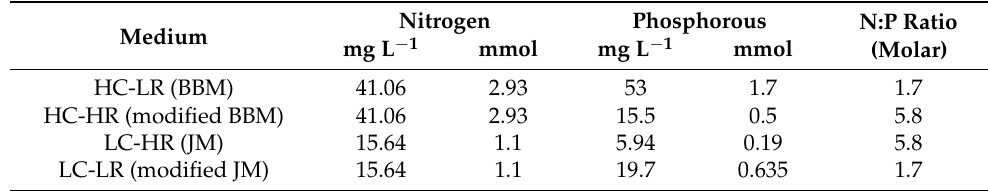
Table 1. Nitrogen and phosphorous contents and N:P ratios of the applied culturing media.